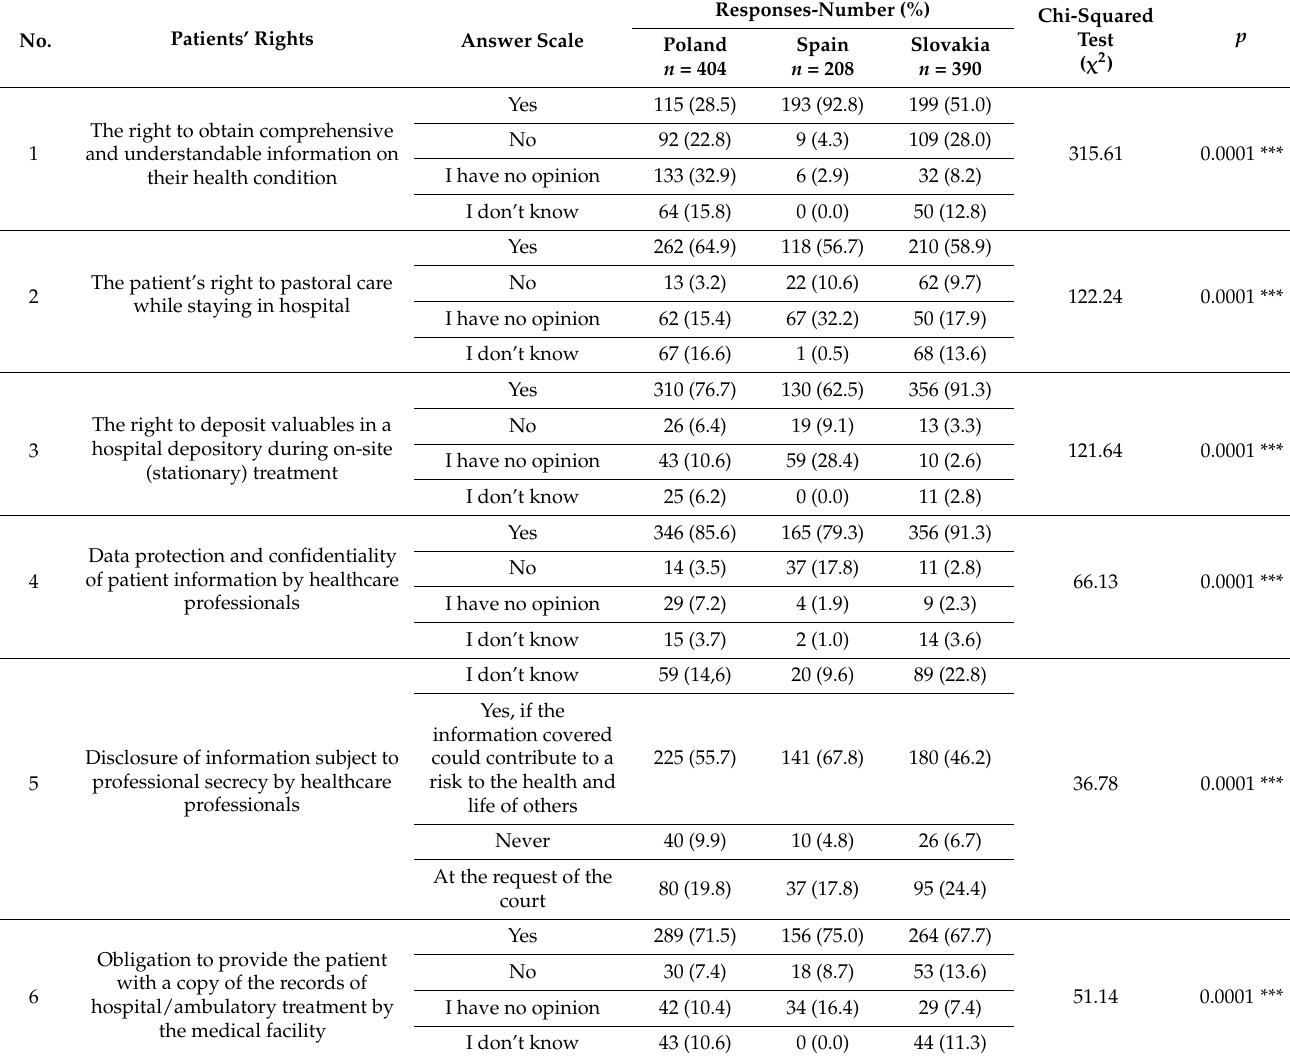
Table 1. Distribution of answers to questions on patients’ rights-a comparative